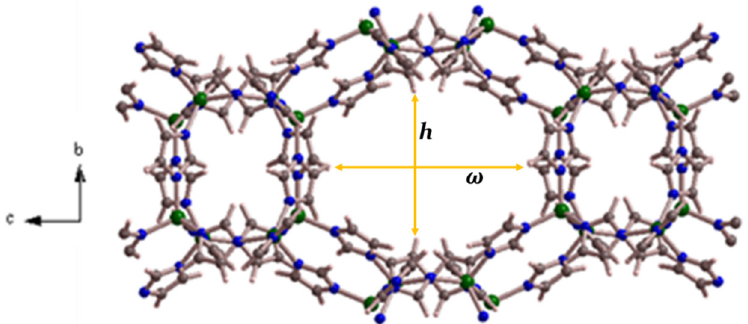
Figure 1. View of crystal structure of ZIF-75 from [1 0 0] crystallographic direction. The meaning of the horizontal and vertical dimensions of the main channels in ZIF-75, 𝜔 and ℎ , is also explained in the figure. Color code: Zn—green; N—blue; C—gray; H—white.